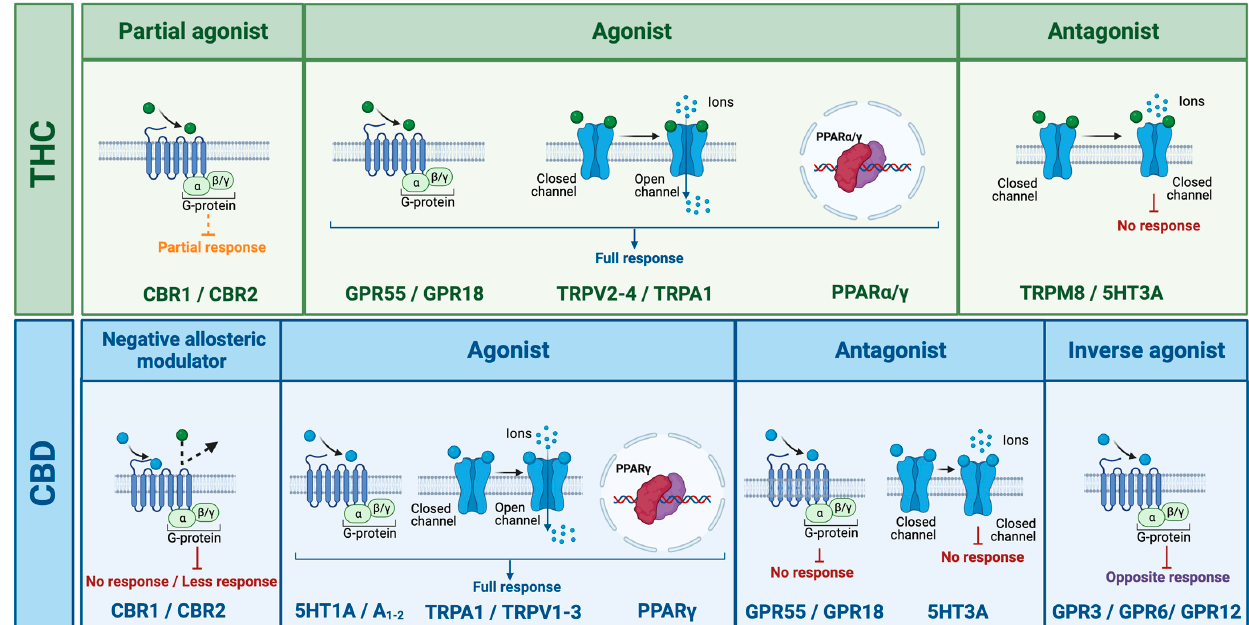
Figure 4. Δ 9-tetrahydrocannabinol (THC) (green) and cannabidiol (CBD) (blue) activity on cannabinoid and non-cannabinoid receptors. Abbreviations: Cannabinoid receptors 1 and 2 (CB1R and CB2R); peroxisome proliferator-activated alfa and gamma (PPAR α - γ ) receptor; orphan G-protein coupled receptors 3, 6, 12, 18, and 55 (GPR3, GPR6, GPR12, GPR18, and GPR55); transient receptor potential of vanilloid 1-4 (TRPV1-4) and ankyrin (TRPA1) channels; TRP cation channel subfamily M member 8 (TRPM8); serotonin 1A and 3A receptor (5-HT3A and 5-HT1A); adenosine receptors 1 and 2 (A 1 and A 2 ).